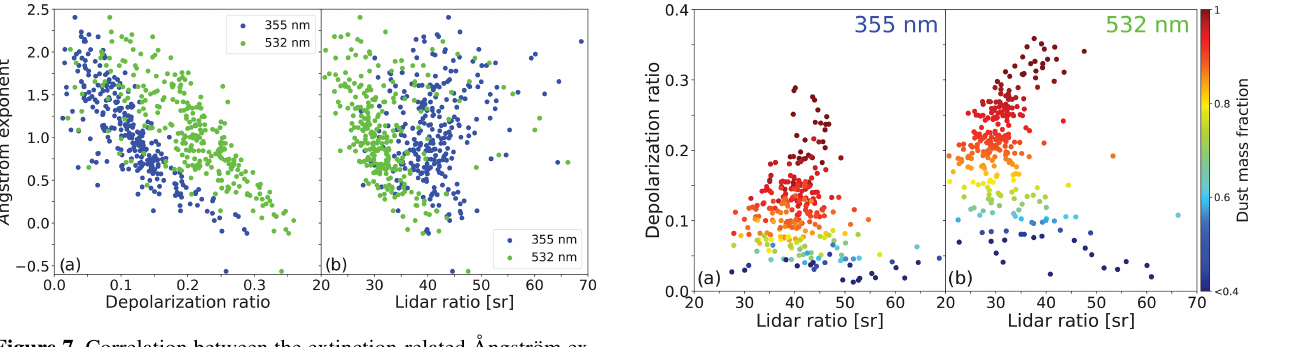
Figure 8. Correlation between (a) the 355nm particle linear depo- larization ratio and the 355nm particle lidar ratio and (b) the 532nm particle linear depolarization ratio and the 532nm particle lidar ra- tio. The depolarization and lidar ratios are color-coded as a function of dust mass